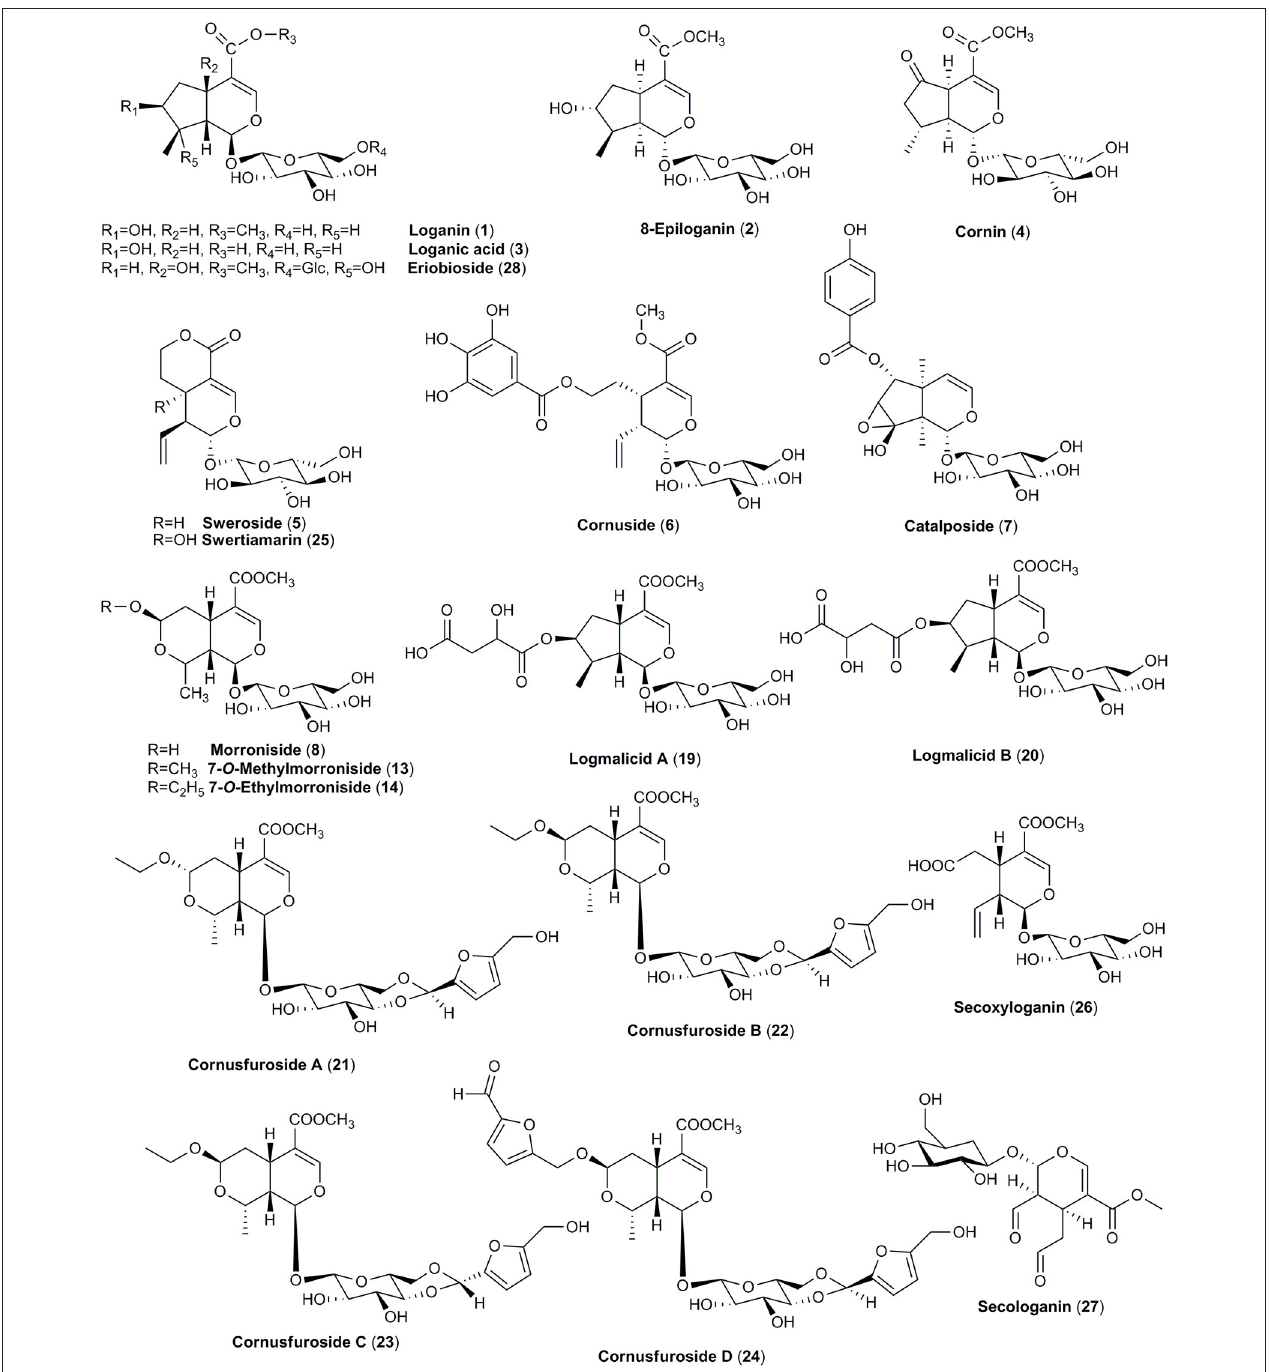
FIGURE 1 | The chemical structures of iridoids identified in fruits of C. mas and/or C. officinalis .